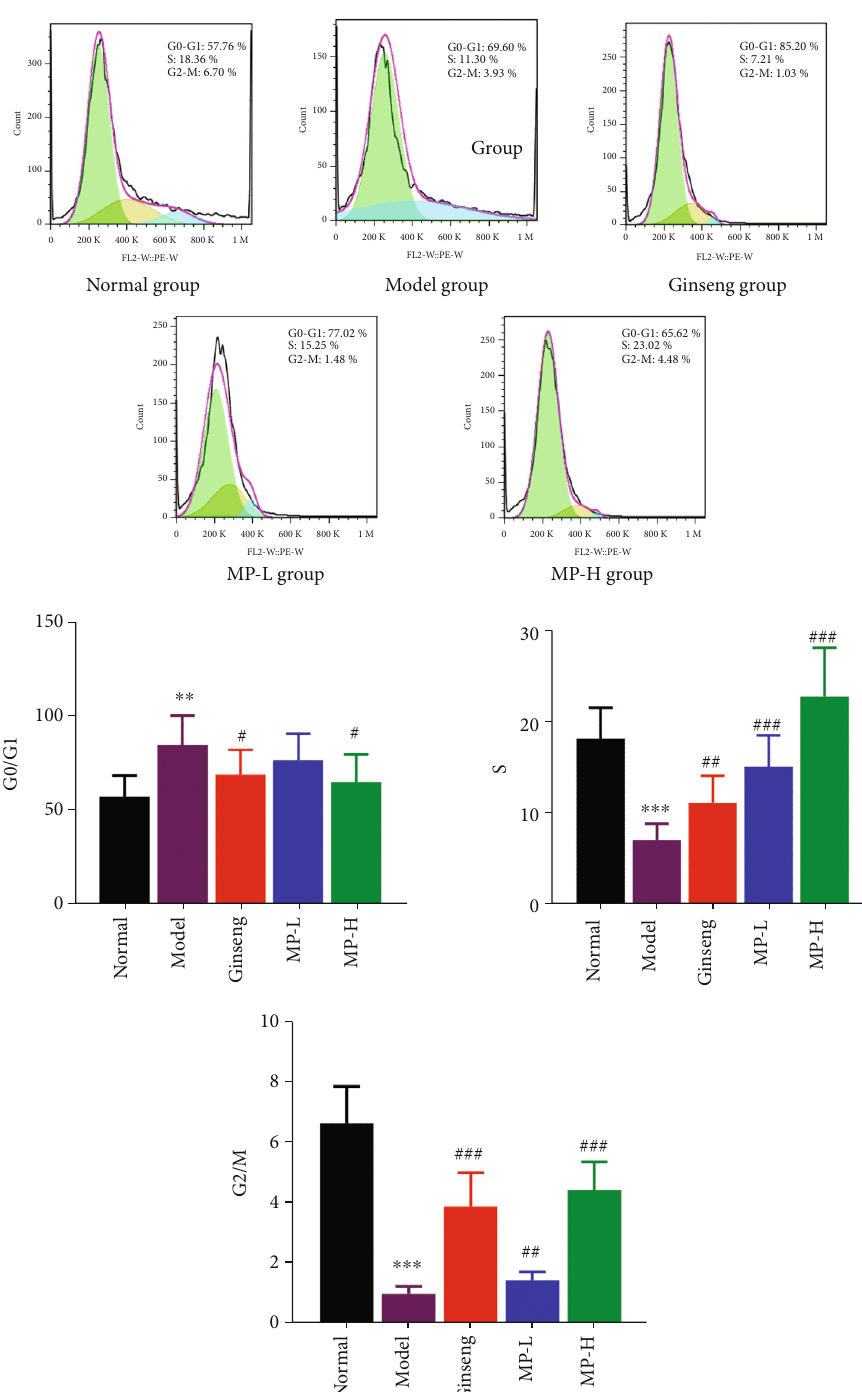
Figure 5: E ff ects of Maca polysaccharides on the peripheral blood lymphocyte cycle ( n = 12 ); ∗∗ p < 0 : 01 and ∗∗∗ p < 0 : 001 vs. control group; # p < 0 : 05 , ## p < 0 : 01 , and ### p < 0 : 001 vs. model